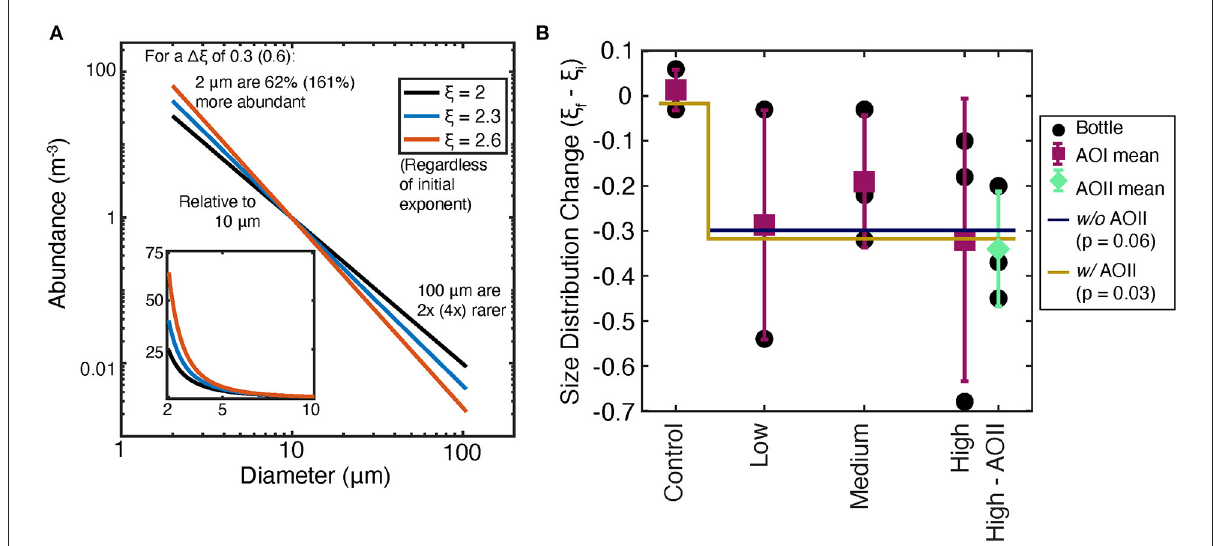
FIGURE6 Analysis of t f particle size distributions from the FlowCam data. (A) shows a schematic of the change in slope on the particle size distribution; (B) shows measured changes in particle size distribution exponents as a function of treatment type for AOI (magenta points) and AOII (teal points), and combined points (“pooled,” magenta with teal